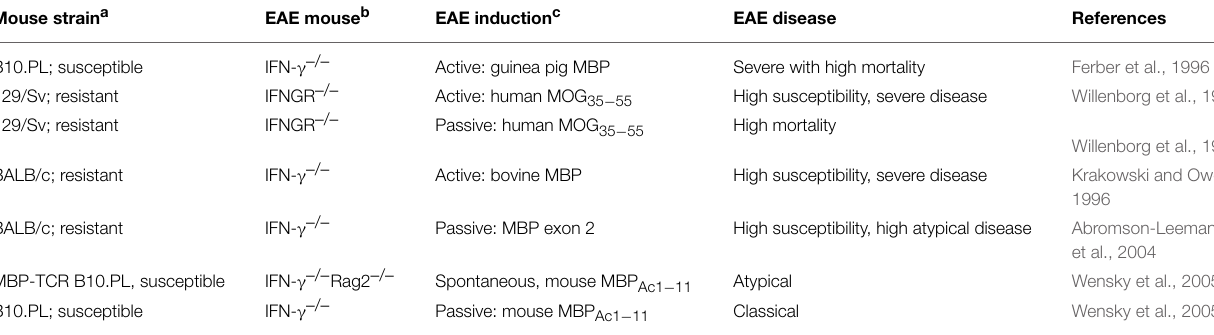
TABLE 1 | Summary of EAE disease susceptibility and presentation in various mouse strains deficient in IFN- γ or its